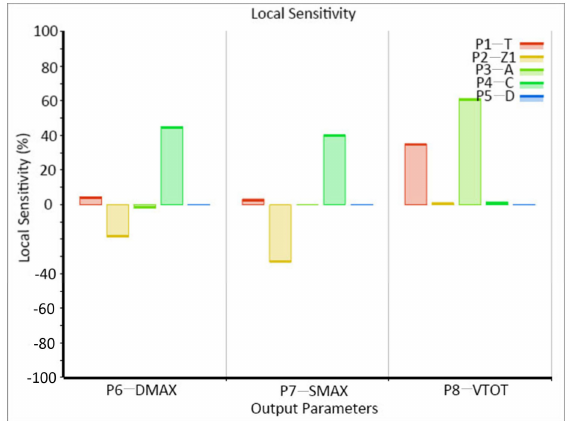
Figure 8. The sensitivity of design variables to objective